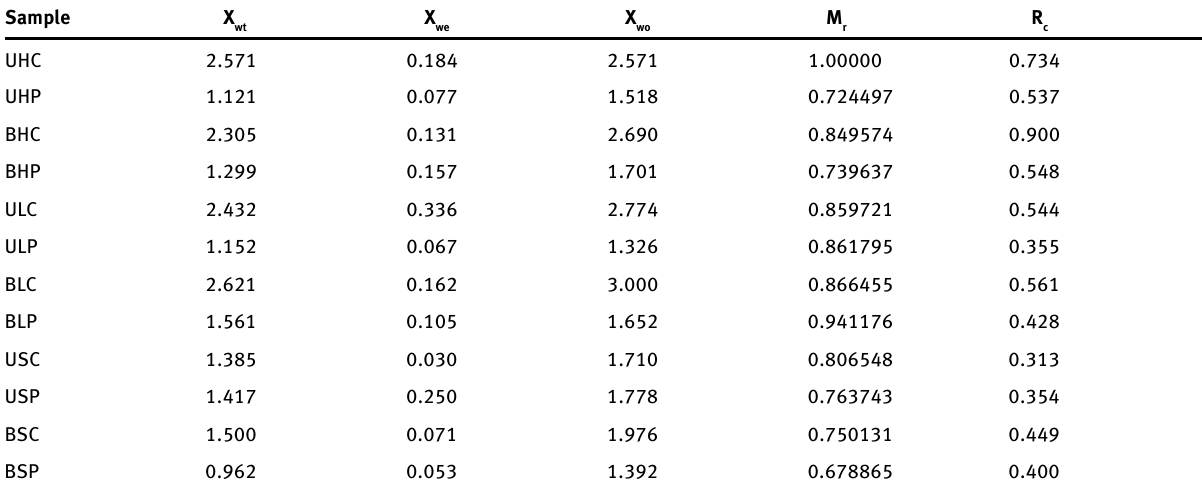
Table 2: Drying Kinetics Parameters of Cardaba Banana and Plantain